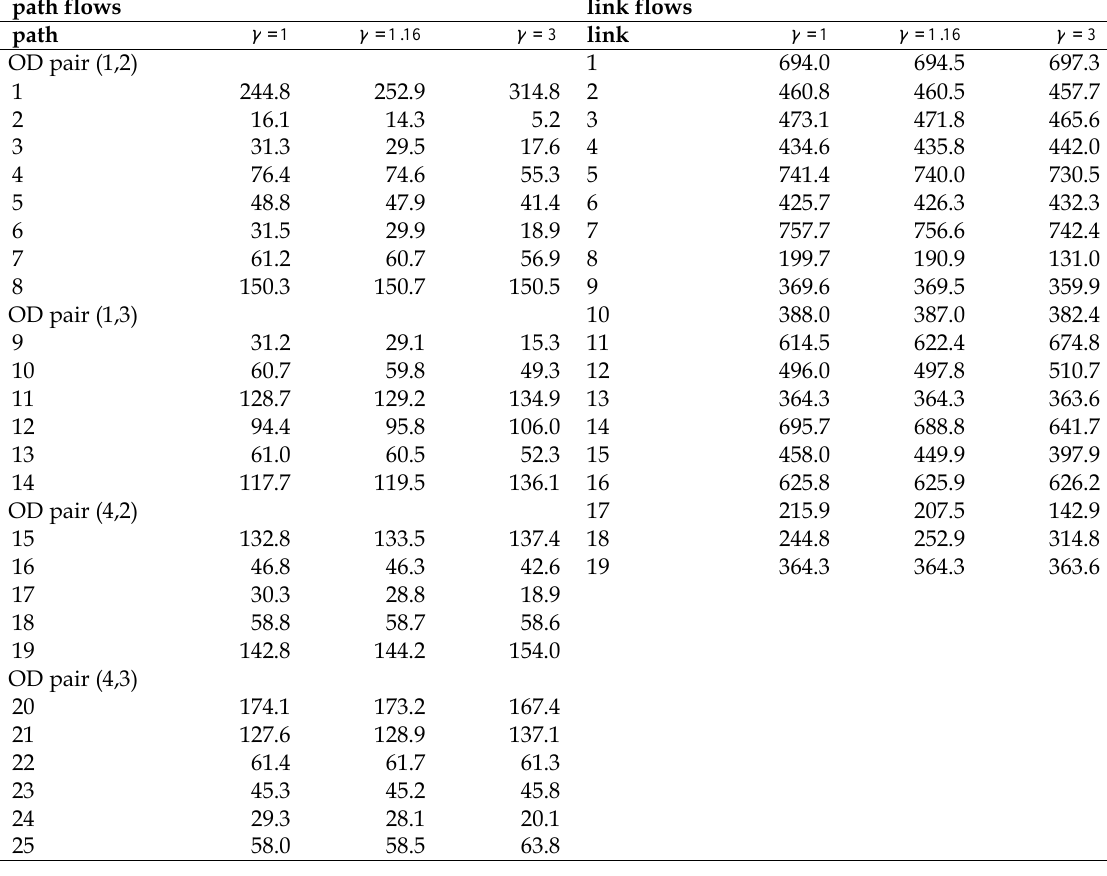
Table 9. Sensitivity of RDSUE path and link flows to loss aversion in the time attribute